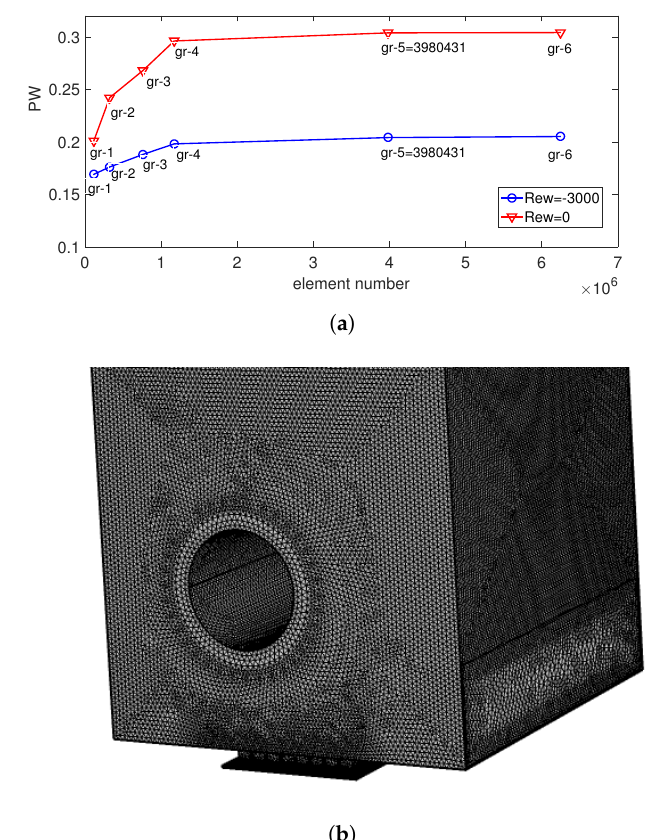
Figure 2. The grid independence test results for the generated power (PW with units in W) at two different Rew for NF1 ( a ) and grid distribution in the domain ( b